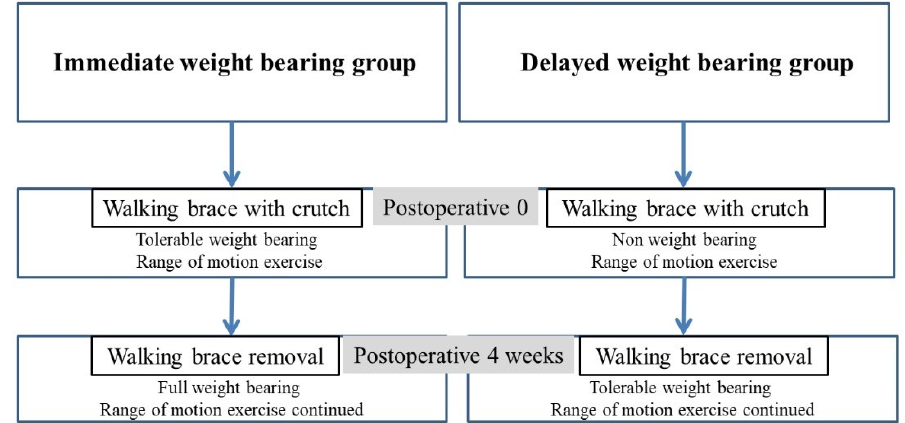
Figure 2. Postoperative rehabilitation protocol after fixation of the lateral malleolar fracture.